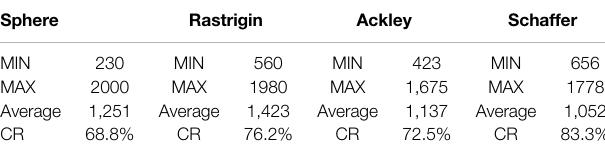
TABLE 4 | Summary of the global performance measures of four benchmark